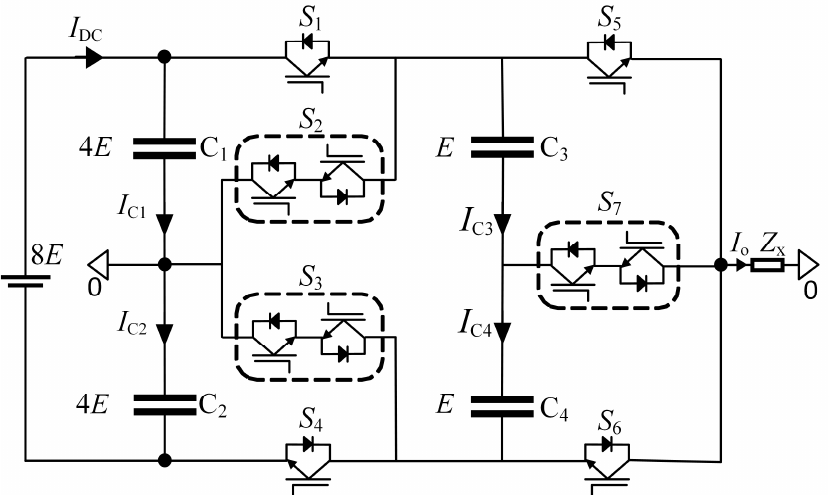
Figure 1. The topology of the proposed 9-level